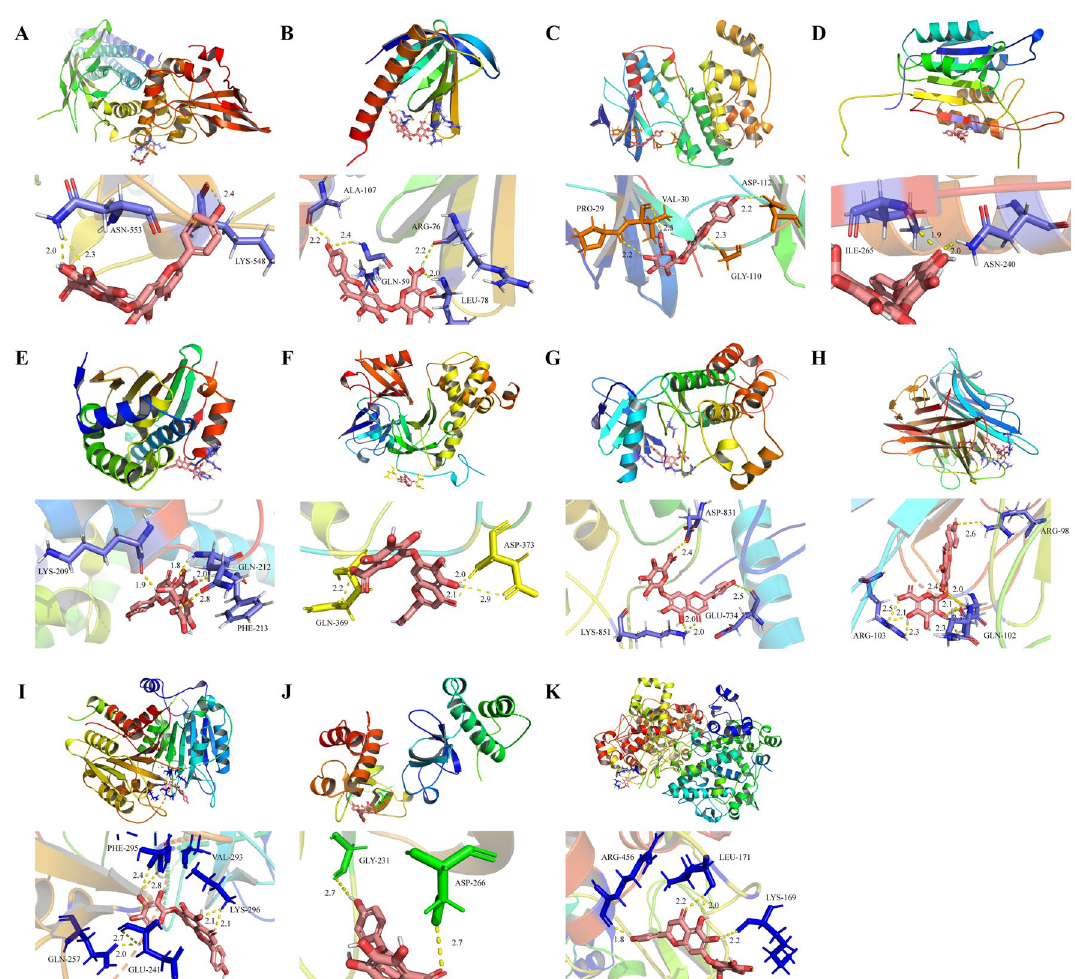
Figure 7. Molecular docking of the hub targets with SCU. ( A ) Binding poses of SCU with STAT3; ( B ) Binding poses of SCU with AKT1; ( C ) Binding poses of SCU with MAPK14; ( D ) Binding poses of SCU with CASP3; ( E ) Binding poses of SCU with HSP90AA1; ( F ) Binding poses of SCU with DNMT1; ( G ) Binding poses of SCU with EGFR; ( H ) Binding poses of SCU with TNF; ( I ) Binding poses of SCU with CASP1; ( J ) Binding poses of SCU with DNMT3B; ( K ) Binding poses of SCU with